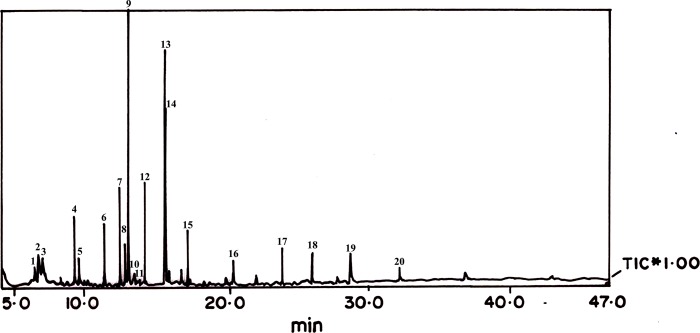
GC-MS chromatogram of crude extract of preputial gland of Millardia meltada.The fractions are Undecane, Dodecane, Tridecane, Decane, Tetradecane, 1-chloro-octadecane, 6-methyl-1-heptanol, (ethenyloxy)-isooctane, 1,3-bis(1,1-dimethylethyl)-benzene, Pentadecane, 1-(3,4-dimethylphenyl)-ethanone, Heptadecane, Farnesol, 4,6-dimethyl dodecane, 1,1’-oxybis-octane, 1-dodecanol, 3,4-dimethyl-heptane, Pentadecane, 3,5-bis(1,1-dimethylethyl)-phenol, and 1-iodo-decane.